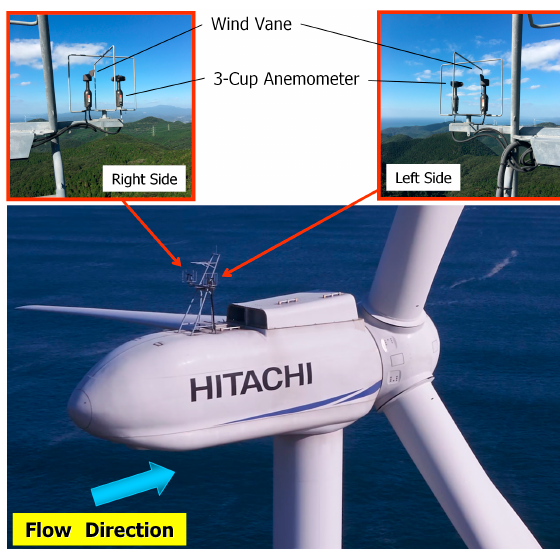
Figure 6. Nacelle propeller-vane anemometer.